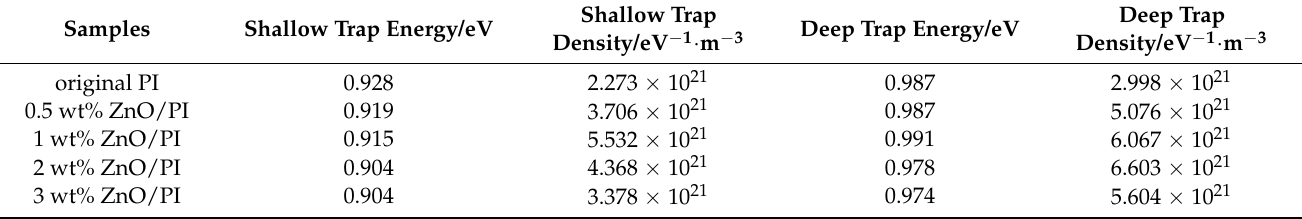
Table 3. Surface trap energy and density of original PI and nanocomposite